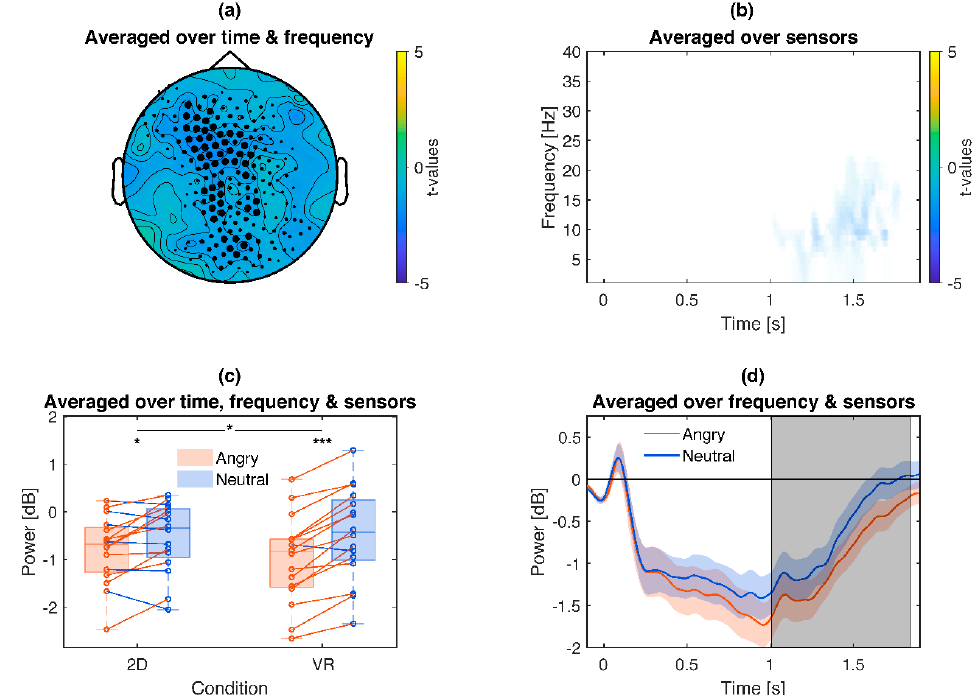
Figure 4. Illustration of the emotional frequency e ff ects: angry pictures lead to a stronger alpha event related desynchronization (ERD), which is even stronger in VR. ( a ): Topography of t -values averaged across the significant time points and frequency bins (see b). The size of the marked sensors is displayed proportional to their contribution to the cluster. ( b ): Time-frequency plot of t -values, averaged across sensors of the respective cluster (see a). Only time-frequency bins which are part of the cluster are displayed. Opaqueness represents the percentage of sensors showing the e ff ect, e.g., nearly opaque time-frequency bins indicate that only few sensors contribute to this e ff ect. ( c ): Box plot and single subject values from the cluster. Red lines indicate a stronger ERD for angry compared to neutral pictures, blue the opposite. Asterisks indicate the significance of exploratory post-hoc group comparisons: *** p < 0.001, * p < 0.05. ( d ): Time course of the respective ERD cluster. Values were averaged over the respective sensors (see a) and frequencies (see b). Colored shaded areas signify standard errors. Grey shaded areas signify the latency of the